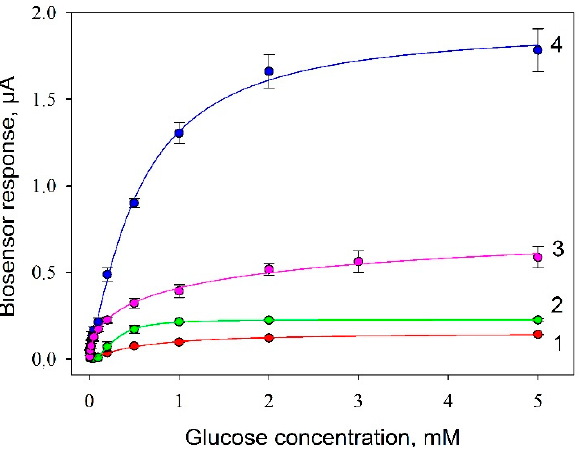
Figure 8. Calibration curves of glucose biosensors with various compositions of composite material